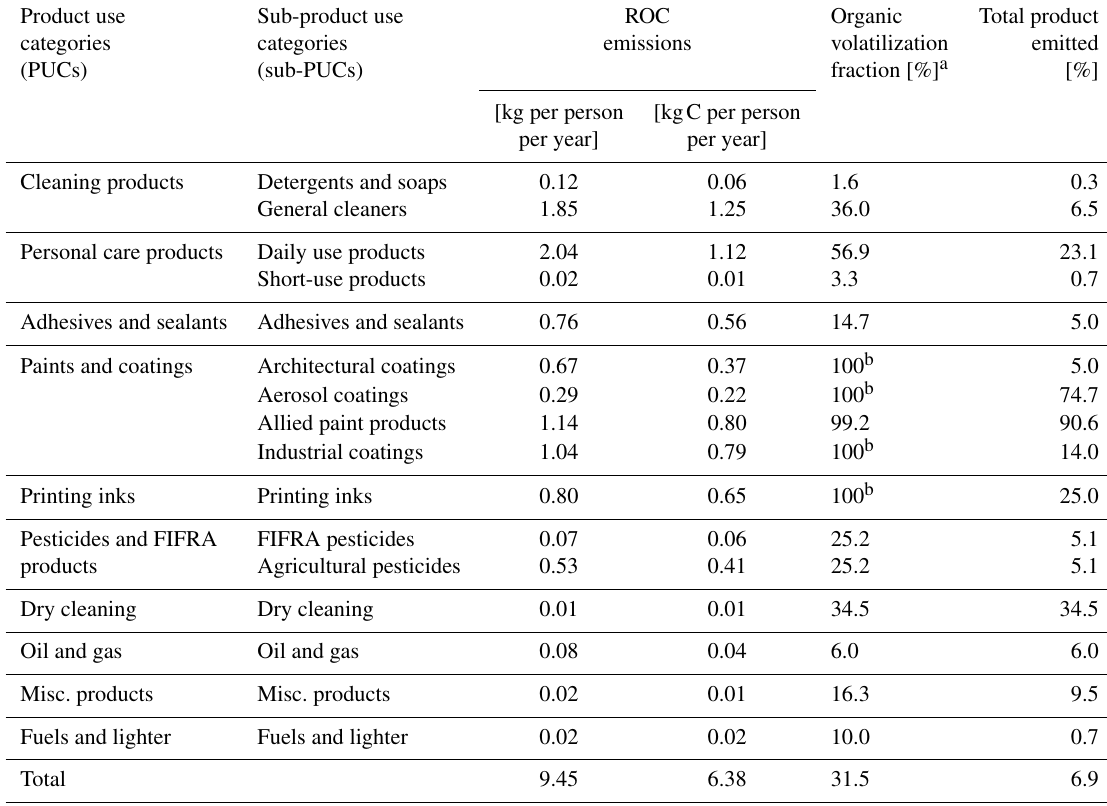
Table 3. National-level emissions, volatilization fraction, and proportion of all usage that is emitted for all sub-PUCs. Product use